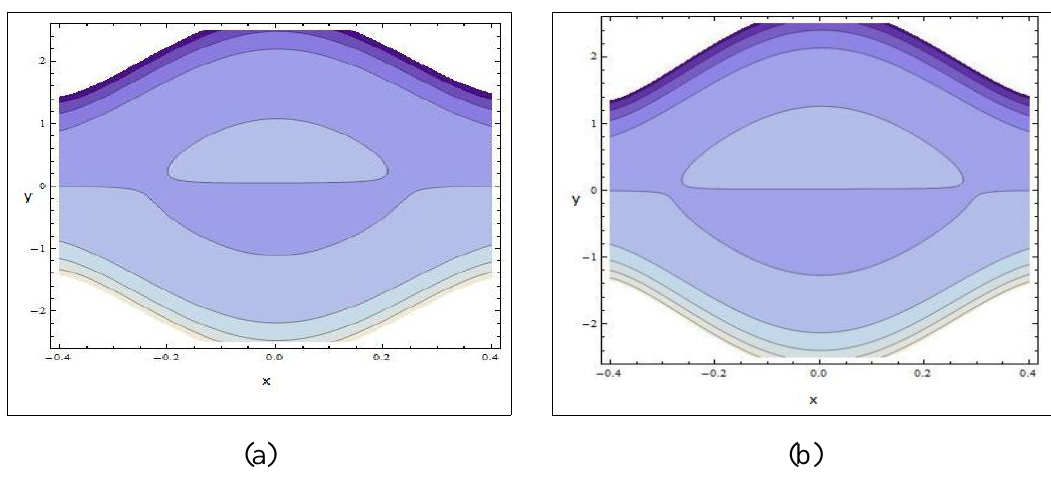
Figure 17. Stream lines for different values of M .( a ) for M = 2.2. ( b ) for M = 2.54. The other parameters are a = 0.7, b = 0.7, d = 1, Θ = λ = 1, k = 0.1, Q = 1.5. 1